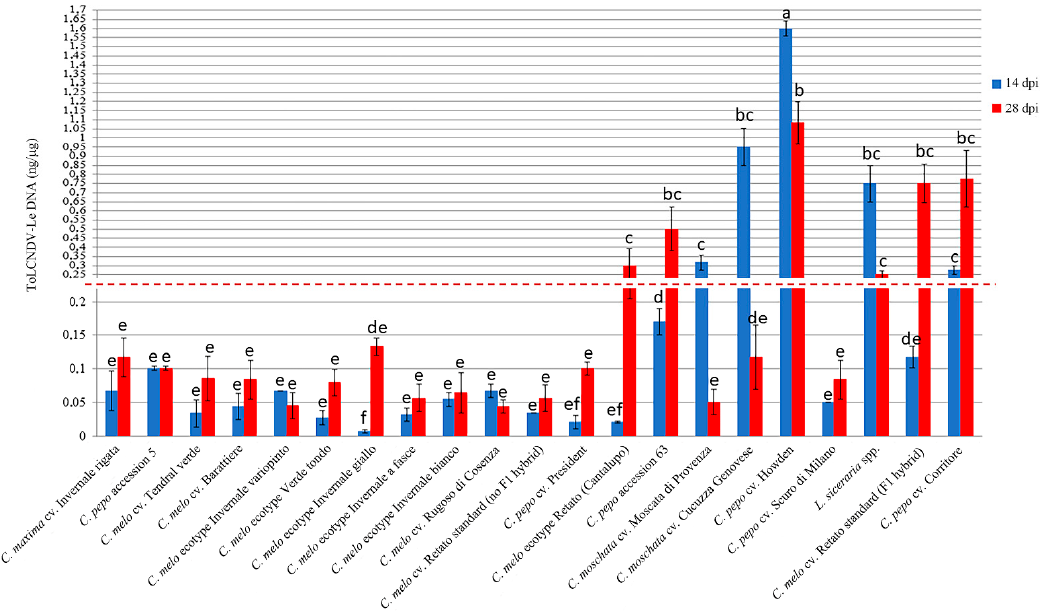
Figure 3. Relative dot-blot quantification of ToLCNDV-Le in systemically infected leaves of the selected 21 Cucurbita spp. at 14 (blue) and 28 (red) dpi. Virus DNA accumulation was assessed in two biological replicates of ten plants each, and two technical replicates by dot-blot hybridization by using a Digoxigenin-labeled DNA probe specific for ToLCNDV CP. The chemiluminescent signal was quantified by Quantity One software (BioRad Laboratories). Five dilutions (1:2) of a standard positive PCR product control were used. Statistically significant differences were calculated for each treatment and indicated with letters for p ≤ 0.05 using Tukey’s post hoc ANOVA test. Vertical bars on columns represent standard deviations among replicates. A significant increase in the accumulation of viral DNA between 14 and 28 dpi was observed in C. melo ecotype Retato (Cantalupo) (15-fold change, fc), C. pepo cv. Corritore